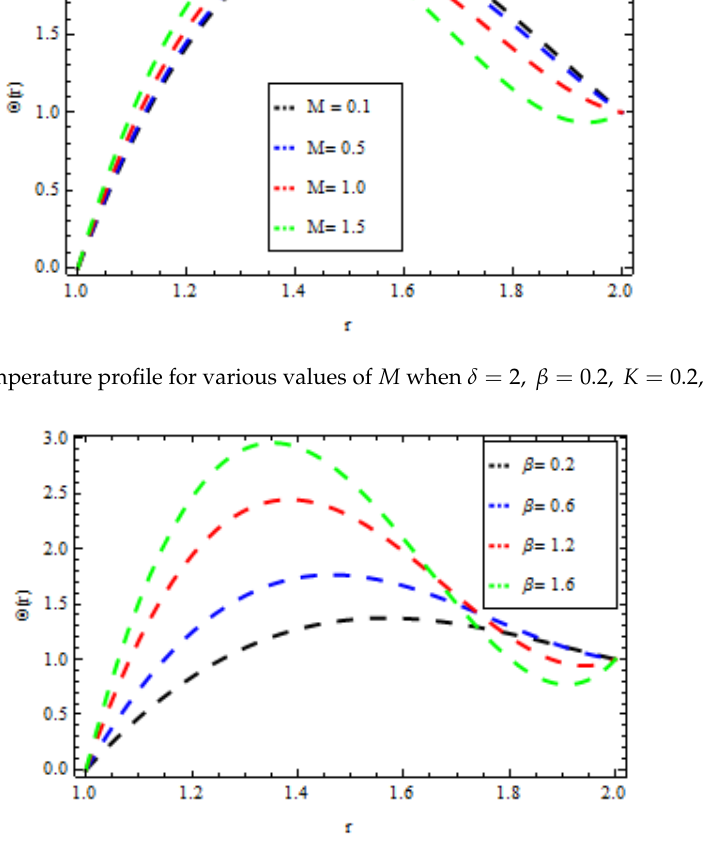
Figure 12. Temperature profile for various values of β when δ = 2, K = 0.2, M = 0.2, Br =